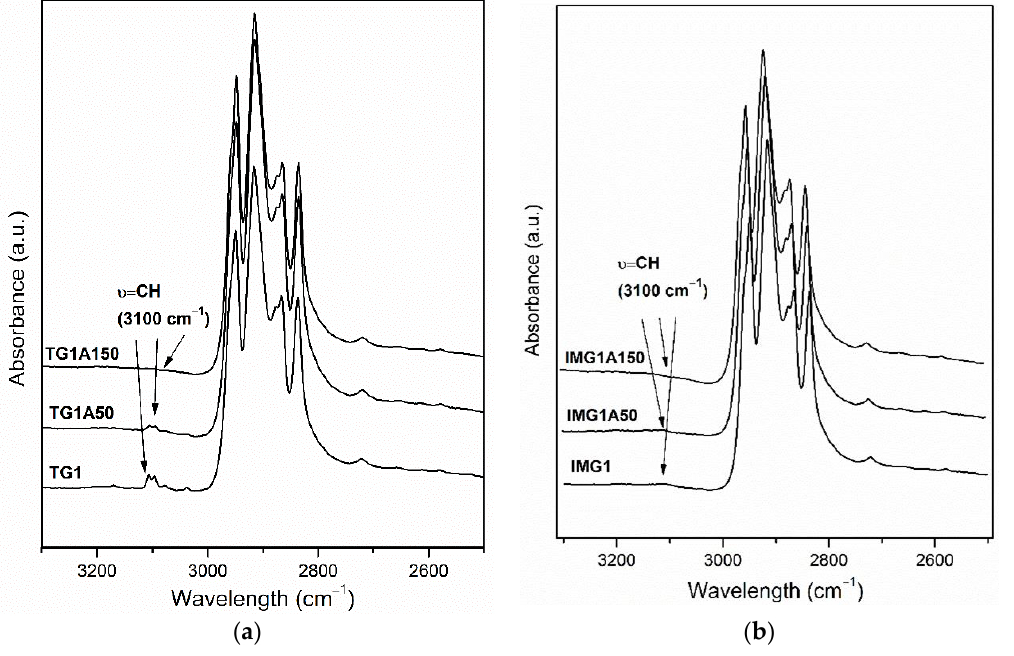
Figure 4. FTIR spectra of TG1 and its annealing products ( a ); and IMG1 and its annealing products ( b ) in the absorption band of 2500 − 3300 cm −1 .